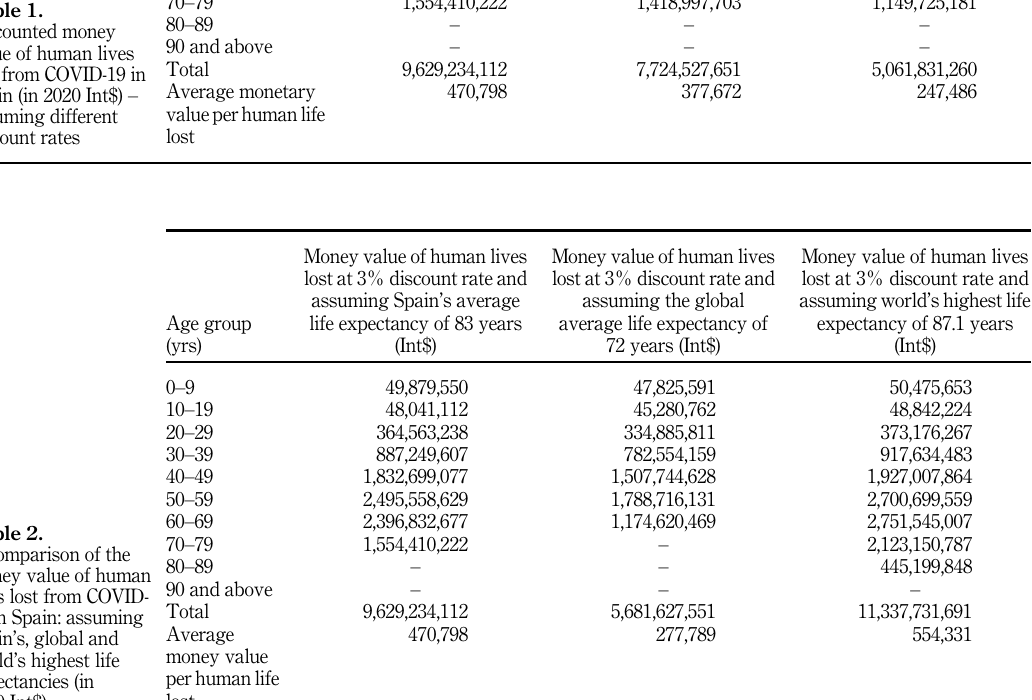
Table 1. Discounted money value of human lives lost from COVID-19 in